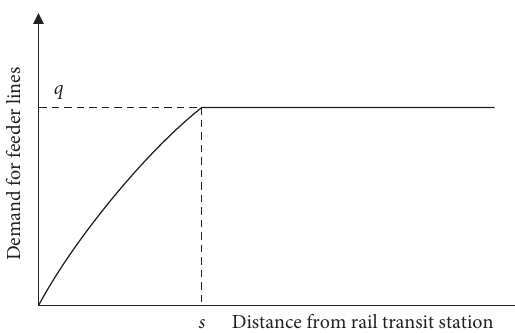
Figure 1: Demand varies with distance from stops to the main rail